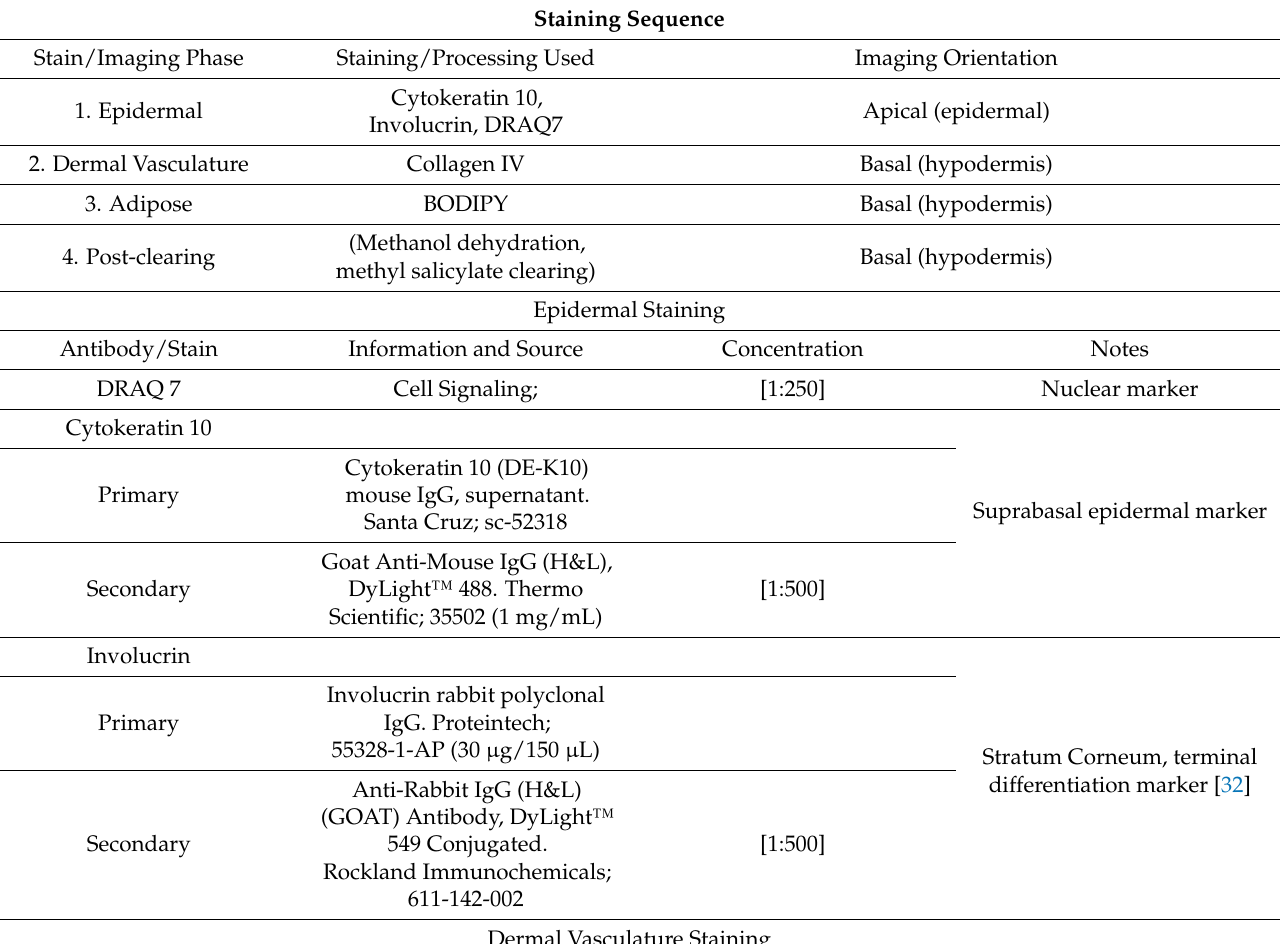
Table 2. Staining sequence, antibodies, and blocking buffer